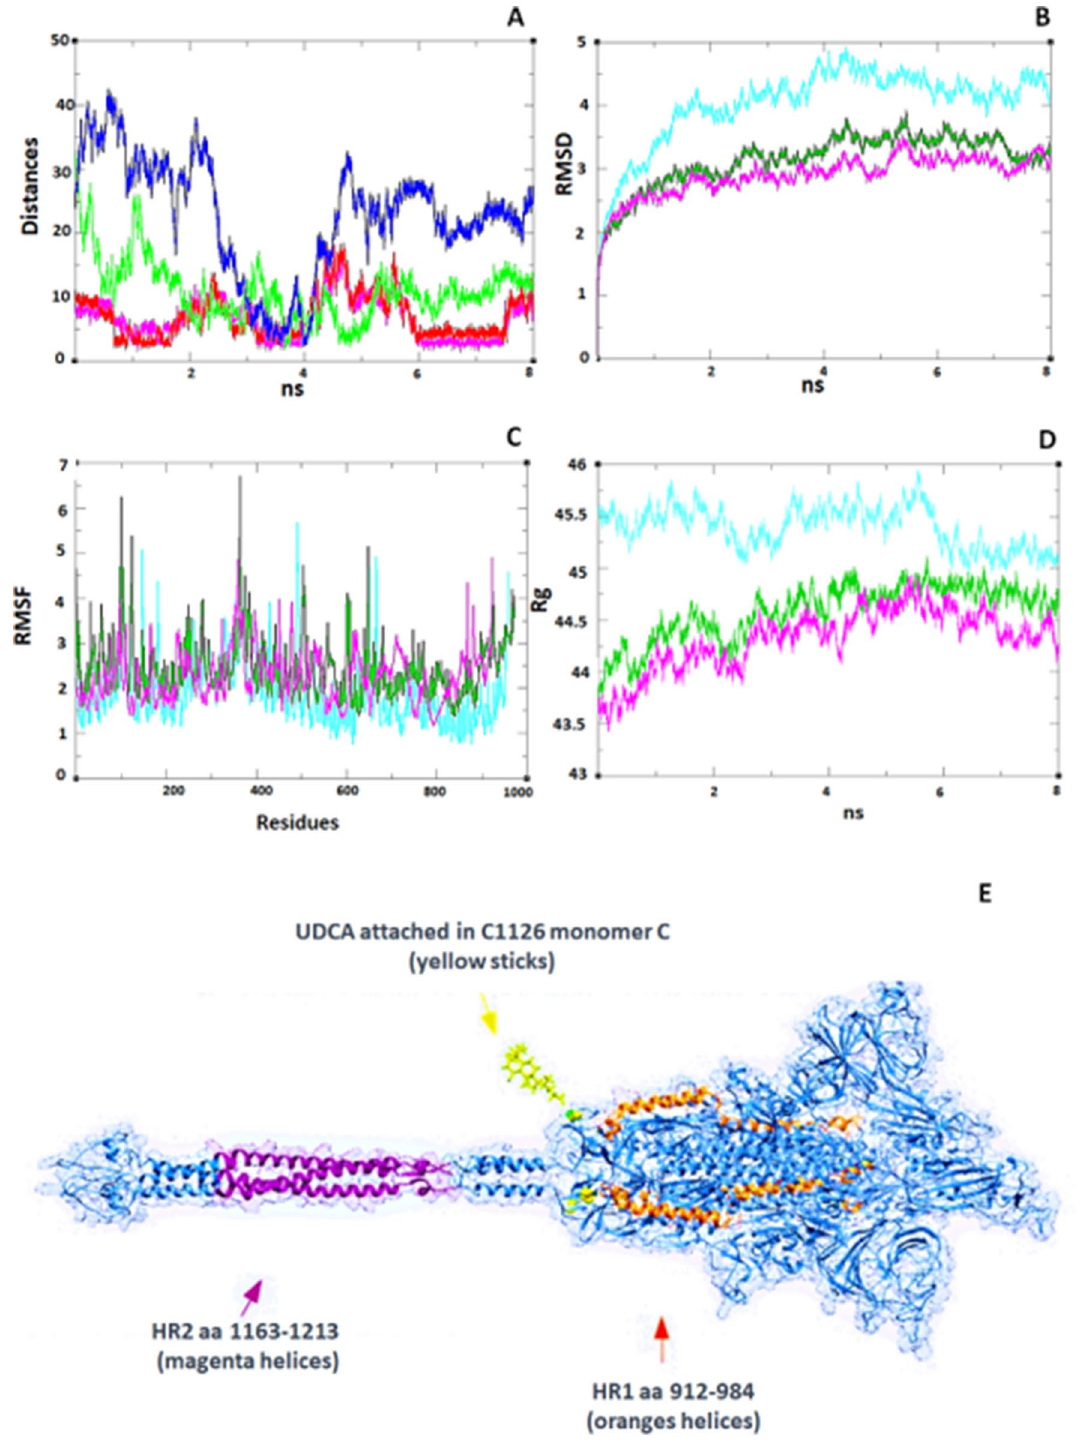
Figure 4. Interaction of UDCA with cysteine residue C1126. ( A ) Distances between UDCA 2908 and C1126 of monomer C (atom O4-UDCA vs HB2-C1126. Atom O4A-UDCA vs HB3-C1126 in magenta and red, respectively). UDCA-2916 interaction with N536 (atom HC11-UDCA vs OD1-N536 in green line). UDCA 2912 interaction with T602 (O4-UDCA vs HB-T602 in blue line). Residues N536 and T602 bind to UDCA momently, instead C1126 binds to UDCA and tends to retain it, thus we think that if UDCA interferes in this region near to HR1-HR2, it could prevent the coiled-coil heptad repeat binding in the area between the HR1 and HR2 regions, necessary for membrane fusion. ( B – D ) (monomer A in turquoise line, B in green line and C in magenta line), respectively. ( E ) General Overview of the Spike protein (taken from charm-gui.org, 6VSB.1.1.1). The HR1 regions of each of the A, B, and C monomers are shown in orange tones. The HR2s are shown in purple tones and the regions to which the UDCA binds in the simulations are shown in yellow (stick representation). Values of RMSD, RMSF and Rg indicates a balanced simulation, although there is a slightly higher value for monomer A, B, and C are very similar. The three UDCA in the MD were differentiated using the Amber nomenclature as UDCA- 2908, UDCA-2916 and